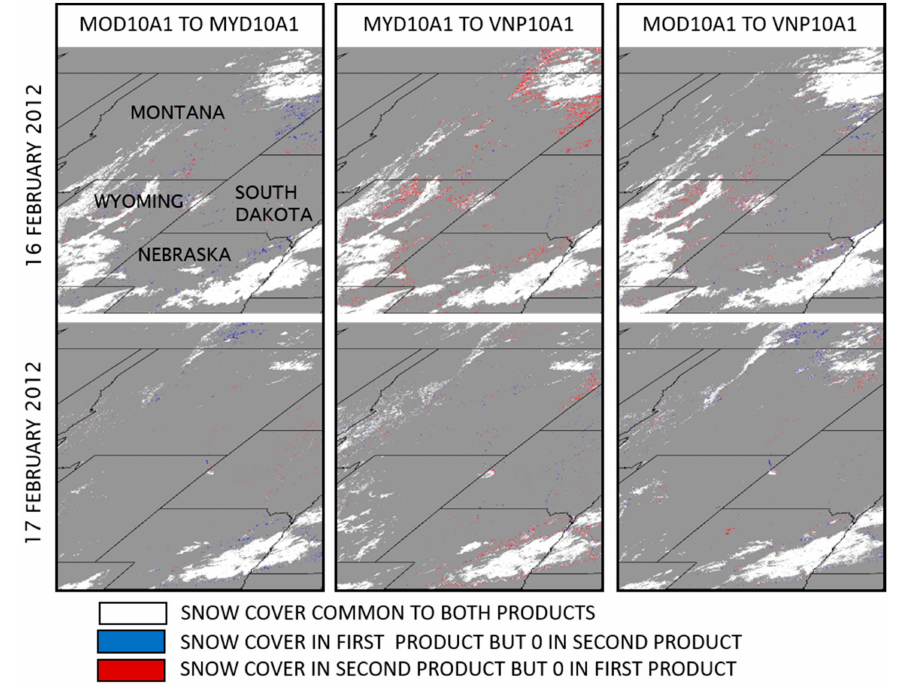
Figure 7. Cell-to-cell SCE comparisons. SCE comparisons for tile h10v04 for 16 February 2012 (top row) and for 17 February 2012 (bottom row). Comparisons are MOD10A1 to MYD10A1 at the left, MYD10A1 to VNP10A1 in the center and MOD10A1 to VNP10A1 at the